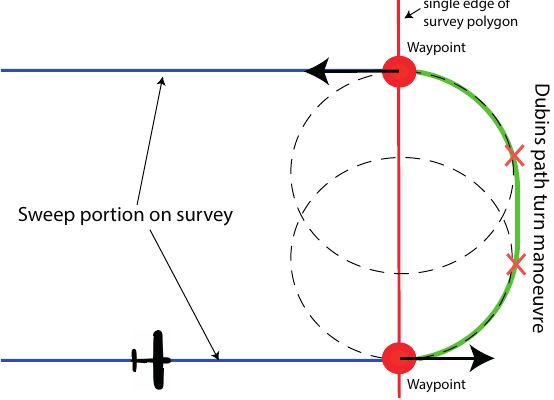
Figure 4. Turn manoeuvre between sweeps in zero wind using Dubins Paths. This demonstrates the fundamental setup for the survey